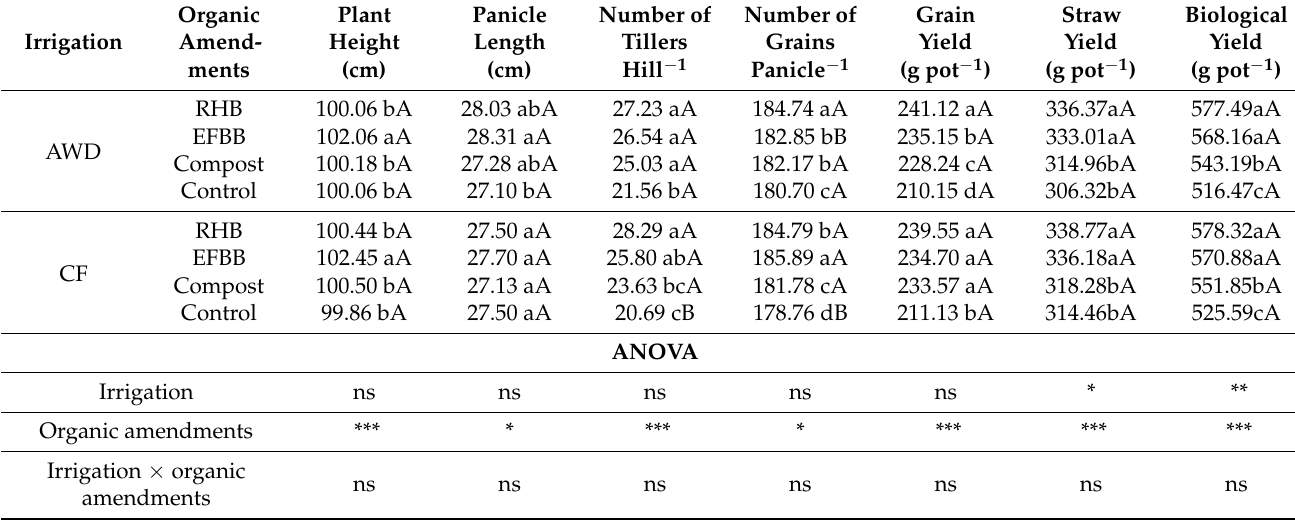
Table 1. Effect of organic amendments and irrigation management on yield and yield-contributing characters of